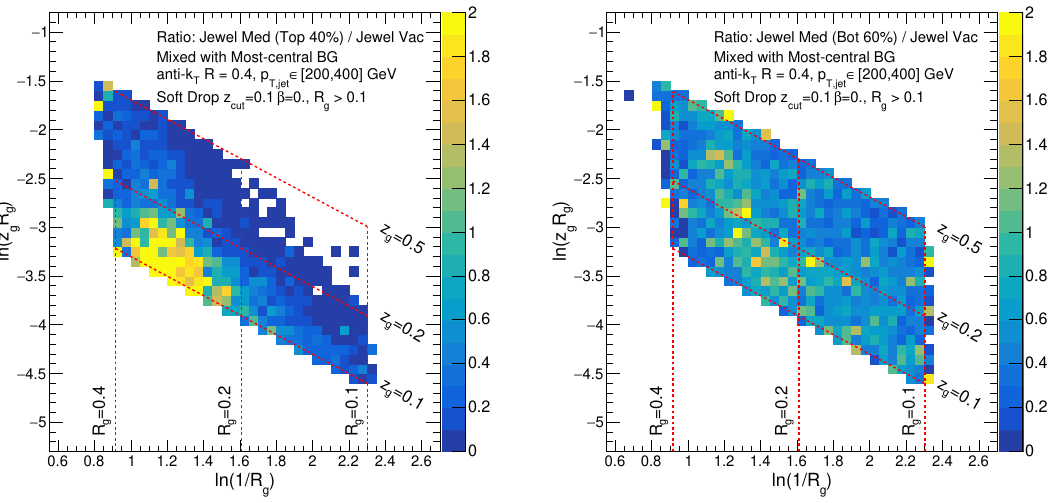
Figure 14 . Primary Lund plane density for the top 40% Jewel medium samples (left) and the bottom 60% samples (right), compared with Jewel vacuum samples.